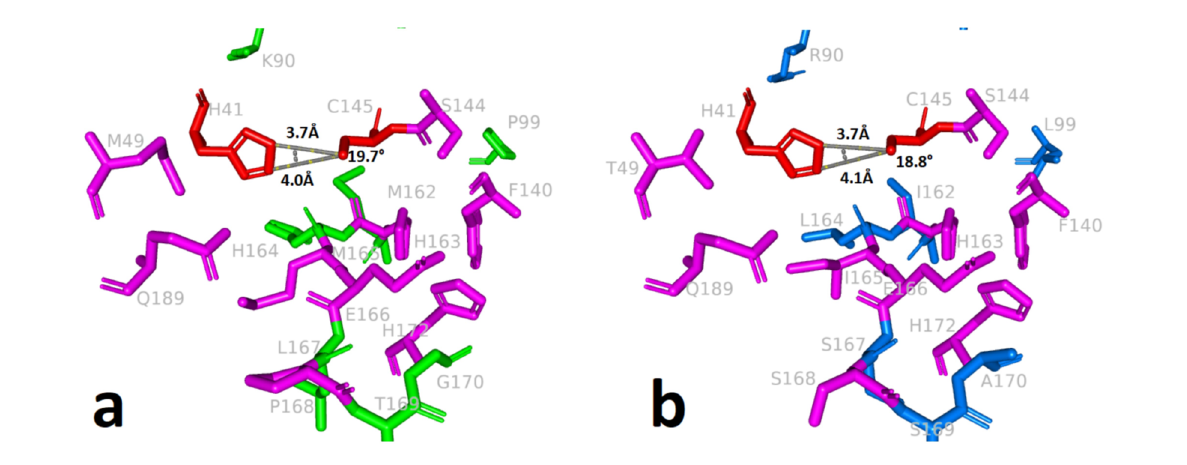
Figure 5 - Conformational change in catalytic residues His 41 and Cys 145 a) wild-type 3CL pro , b) mutant 3CL pro .